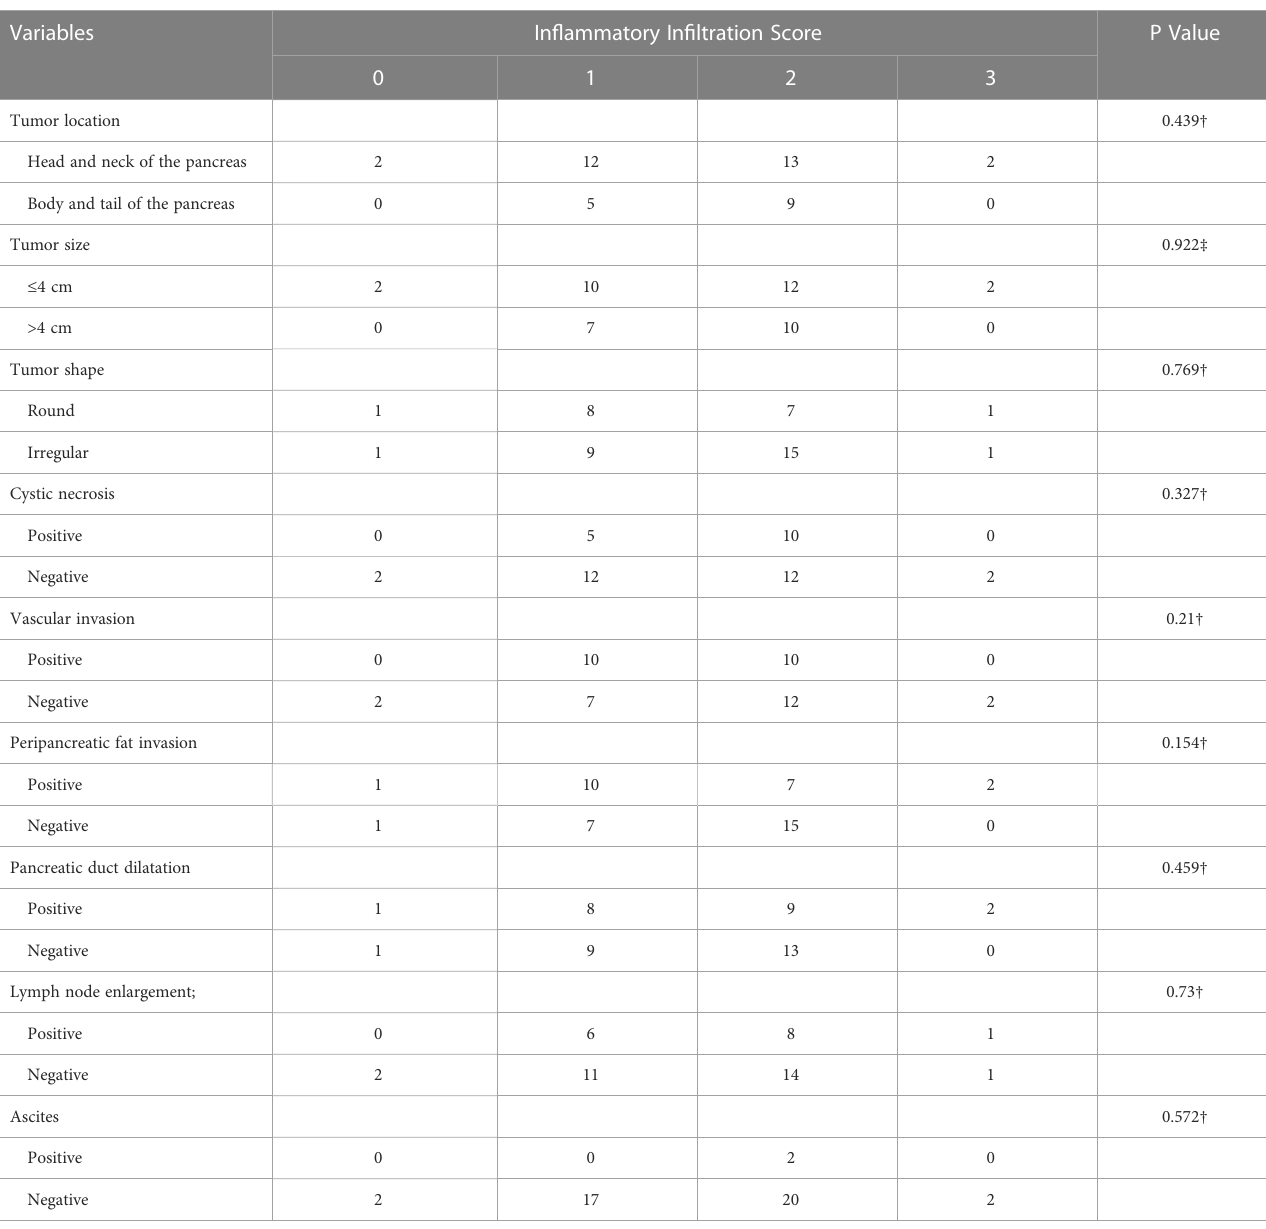
TABLE 2 Correlations between radiologic features and in fl ammatory cell in fi ltration degrees.